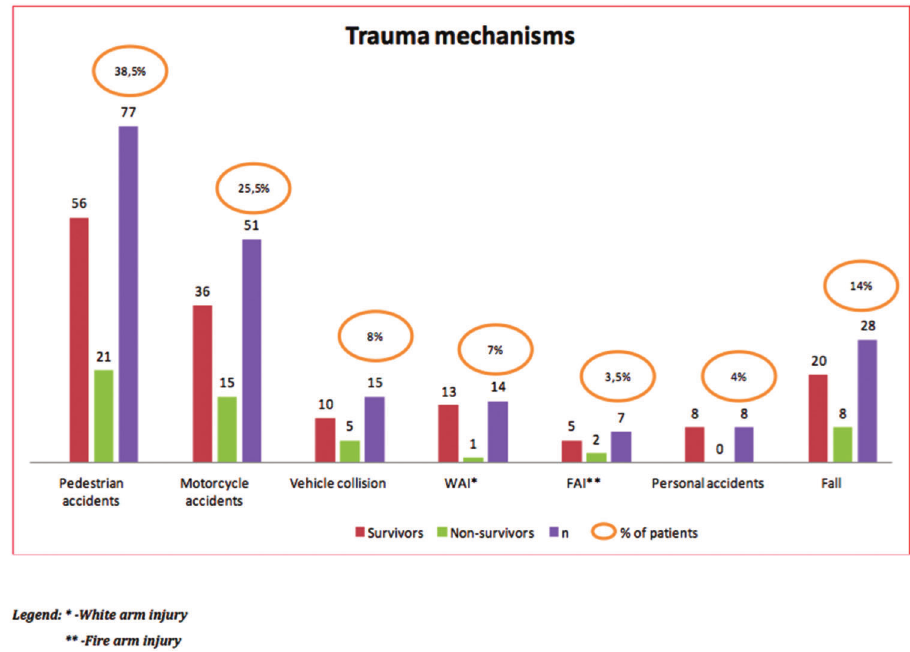
Figure 2 - Comparison of the absolute numbers of the types of trauma mechanisms between the survivor and non-survivor groups.